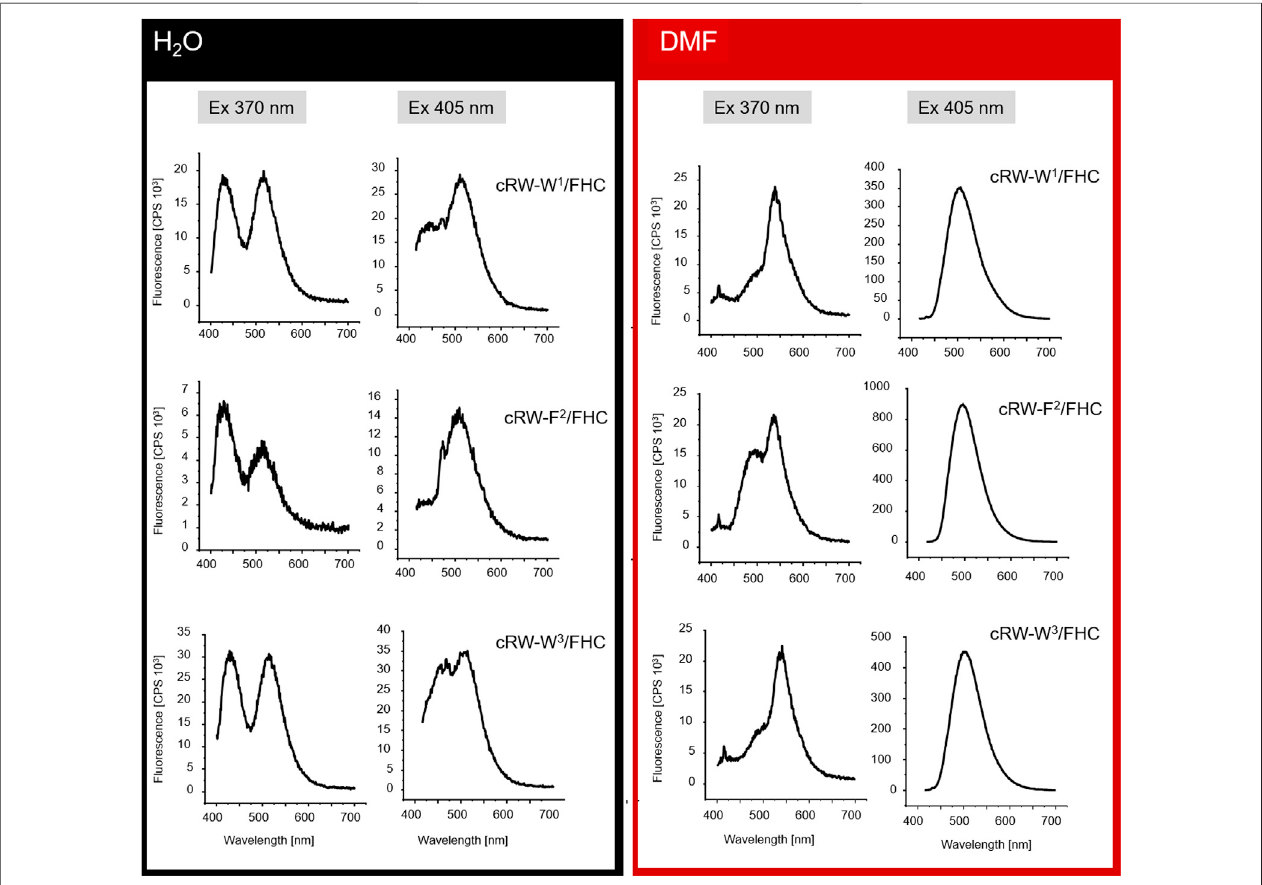
FIGURE 4 | Fluorescence spectra (not normalized) from 8 µM solutions of the FHC-labeled cWFW analogues in H 2 O and DMF under different excitation wavelengths (indicated as “ Ex 370 nm ” and “ Ex 405 nm ” ).